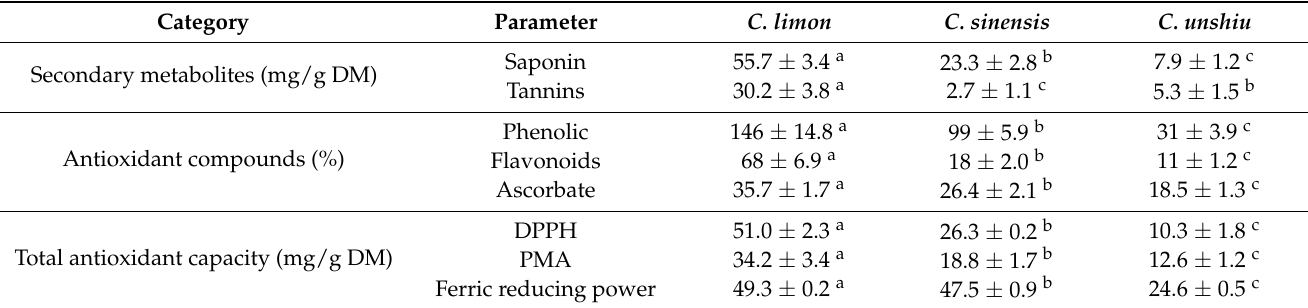
Table 7. Phytochemical screening of bioactive components of C. limon , C. sinensis, and C. unshiu leaf